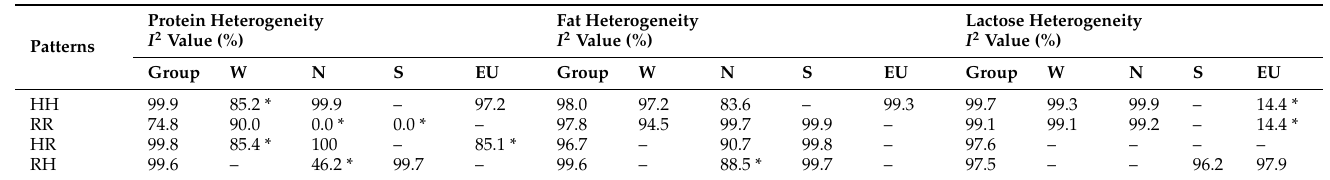
Table 5. Values of subgroup with the